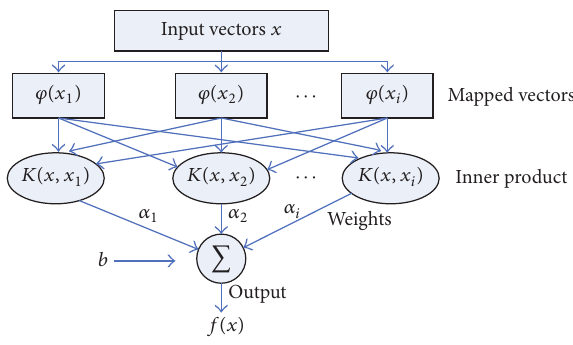
Figure 2: The architecture of